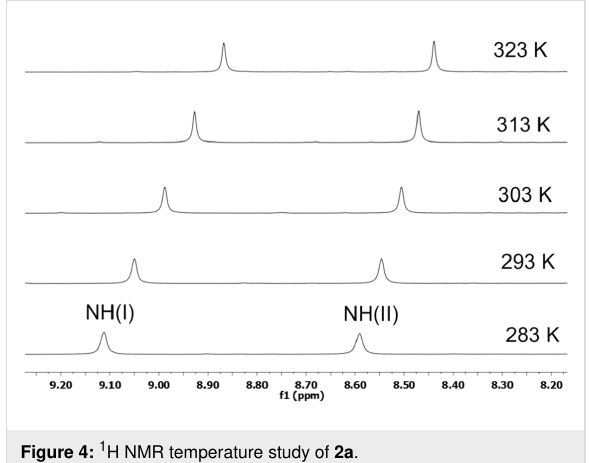
Figure 4: 1 H NMR temperature study of 2a .